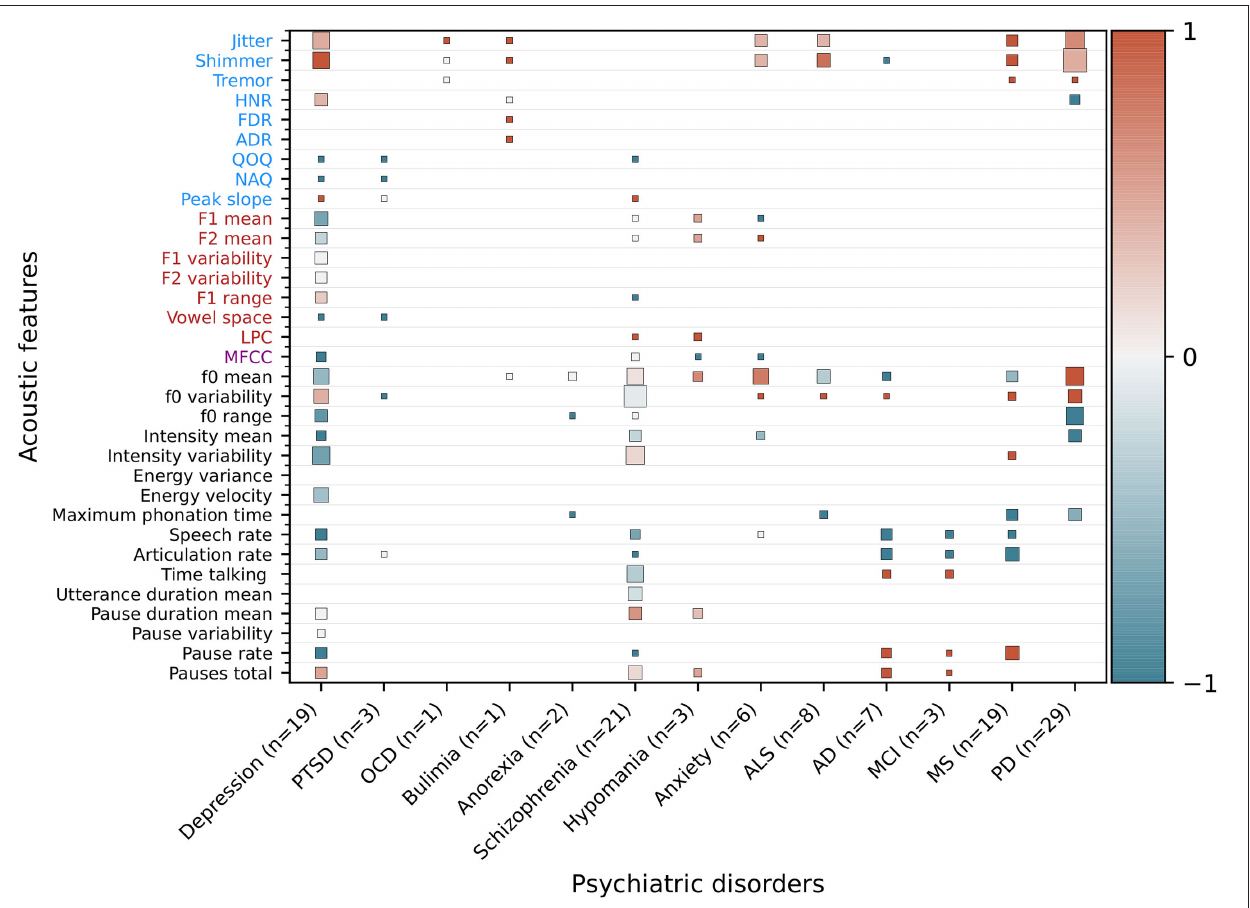
FIGURE 5 | Extended heatmap based on Figure 3 from Low et al. (17). In addition to psychiatric disorders, significantly correlating features from neurodegenerative disorders were extracted and added based on recent reviews of the respective disorders. Features that are significantly higher in a psychiatric population than healthy controls or that correlate positively with the severity of a disorder receive a score of 1 (red), features that are lower or correlate negatively receive a score of –1 (blue), and non-significant or contradicting findings receive a score of 0 (gray). The mean is computed for features with multiple results. The cell size is weighted by the number of studies. Features not studied in a disorder are blank. Additionally, the number of studies (n), of which the correlating features are extracted, is given for each disorder. OCD, obsessive-compulsive disorder; PTSD, post-traumatic stress disorder; ALS, amyotrophic lateral sclerosis; ALS, amyotrophic lateral sclerosis; AD, Alzheimer’s disease; MCI, mild cognitive impairment; MS, multiple sclerosis; PD, Parkinson’s